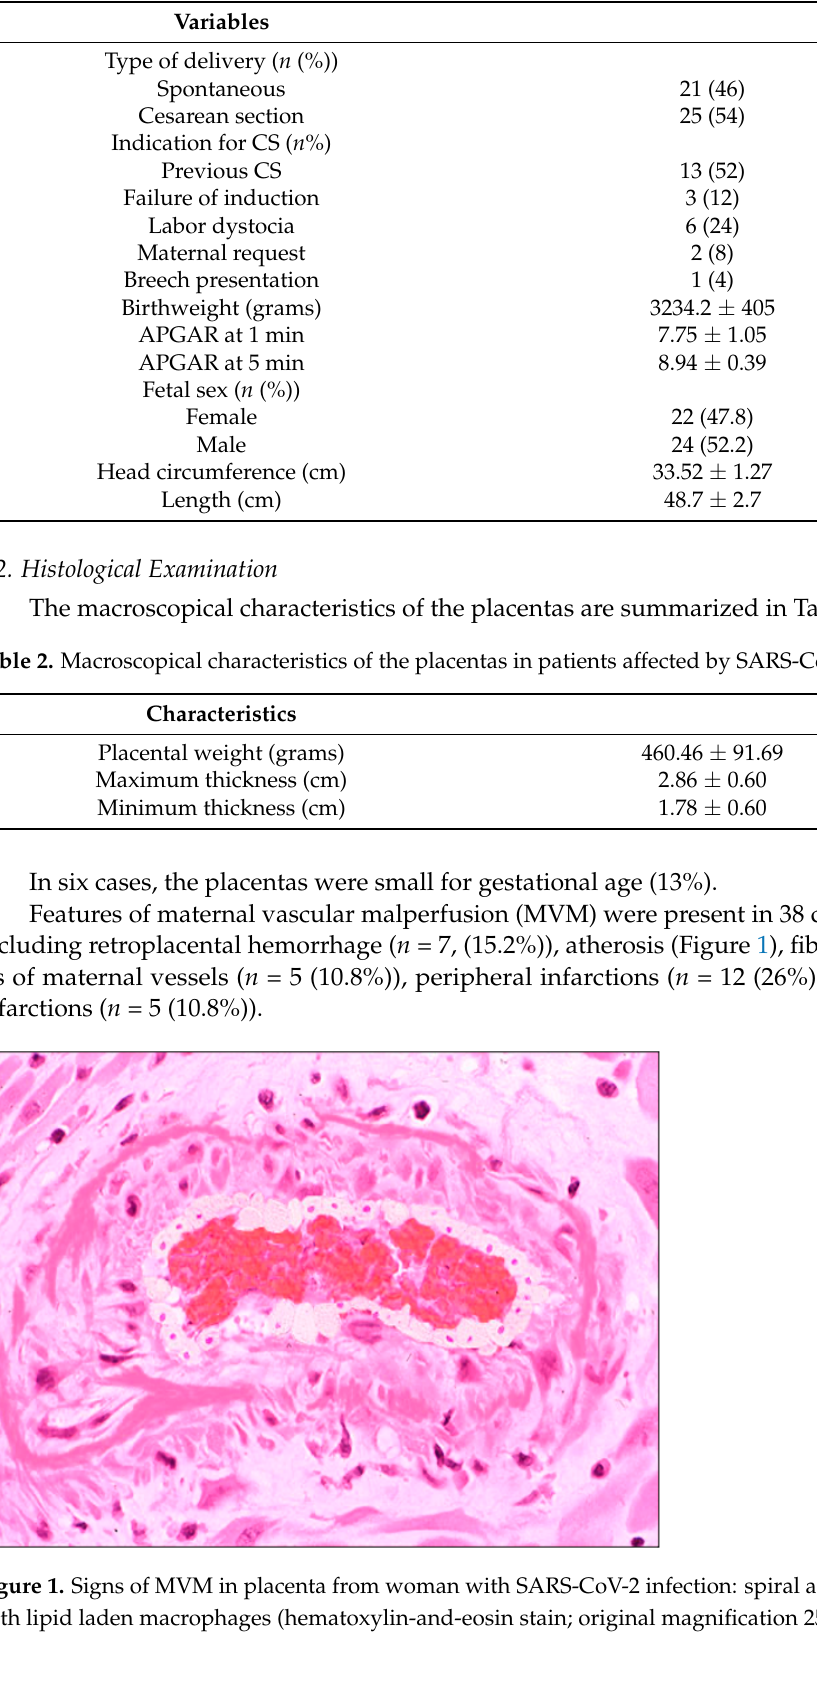
Figure 2. Signs of FVM in placenta from woman with SARS-CoV-2 infection. ( a ) Delayed villous maturation: increased number of large distal villi, with increased capillaries ( ↓ ), stromal macro- phages (  ), and diffused stromal oedema (hematoxylin-and-eosin stain; original magnification 10×). ( b ) Third trimester placenta with fibrosis of the villi and mural fibrin deposition (hematoxylin-and- eosin stain; original magnification 10×). One case (2.2%) showed acute/chronic mixed inflammatory infiltrate, as per low his- tologic chorioamnionitis. Twenty-two placentas (47.8%) showed areas of calcification. The placenta of the patient who required ventilatory support presented chorangiosis and subcentimetric chorioangioma (Figure 3). Figure 3. Placental chorioangioma in a woman with SARS-CoV2 infection ( → ) (hematoxylin-and- eosin stain; original magnification 10×). Patients were divided into three groups according to the grade of blood circulation disease: absence of blood circulation disease ( n = 4 (8.7%)), blood circulation disease of low/moderate grade ( n = 25 (54.3%)), and blood circulation disease of severe grade ( n = 17